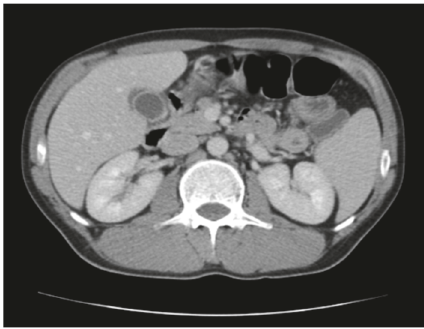
Figure 3: CT-scan of the abdomen showing thickening of the gallbladder wall and pericholecystic fluid collection.